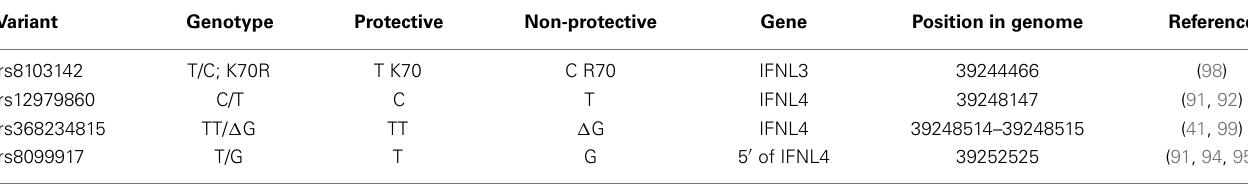
Table 2 | SNPs at the IFNL locus